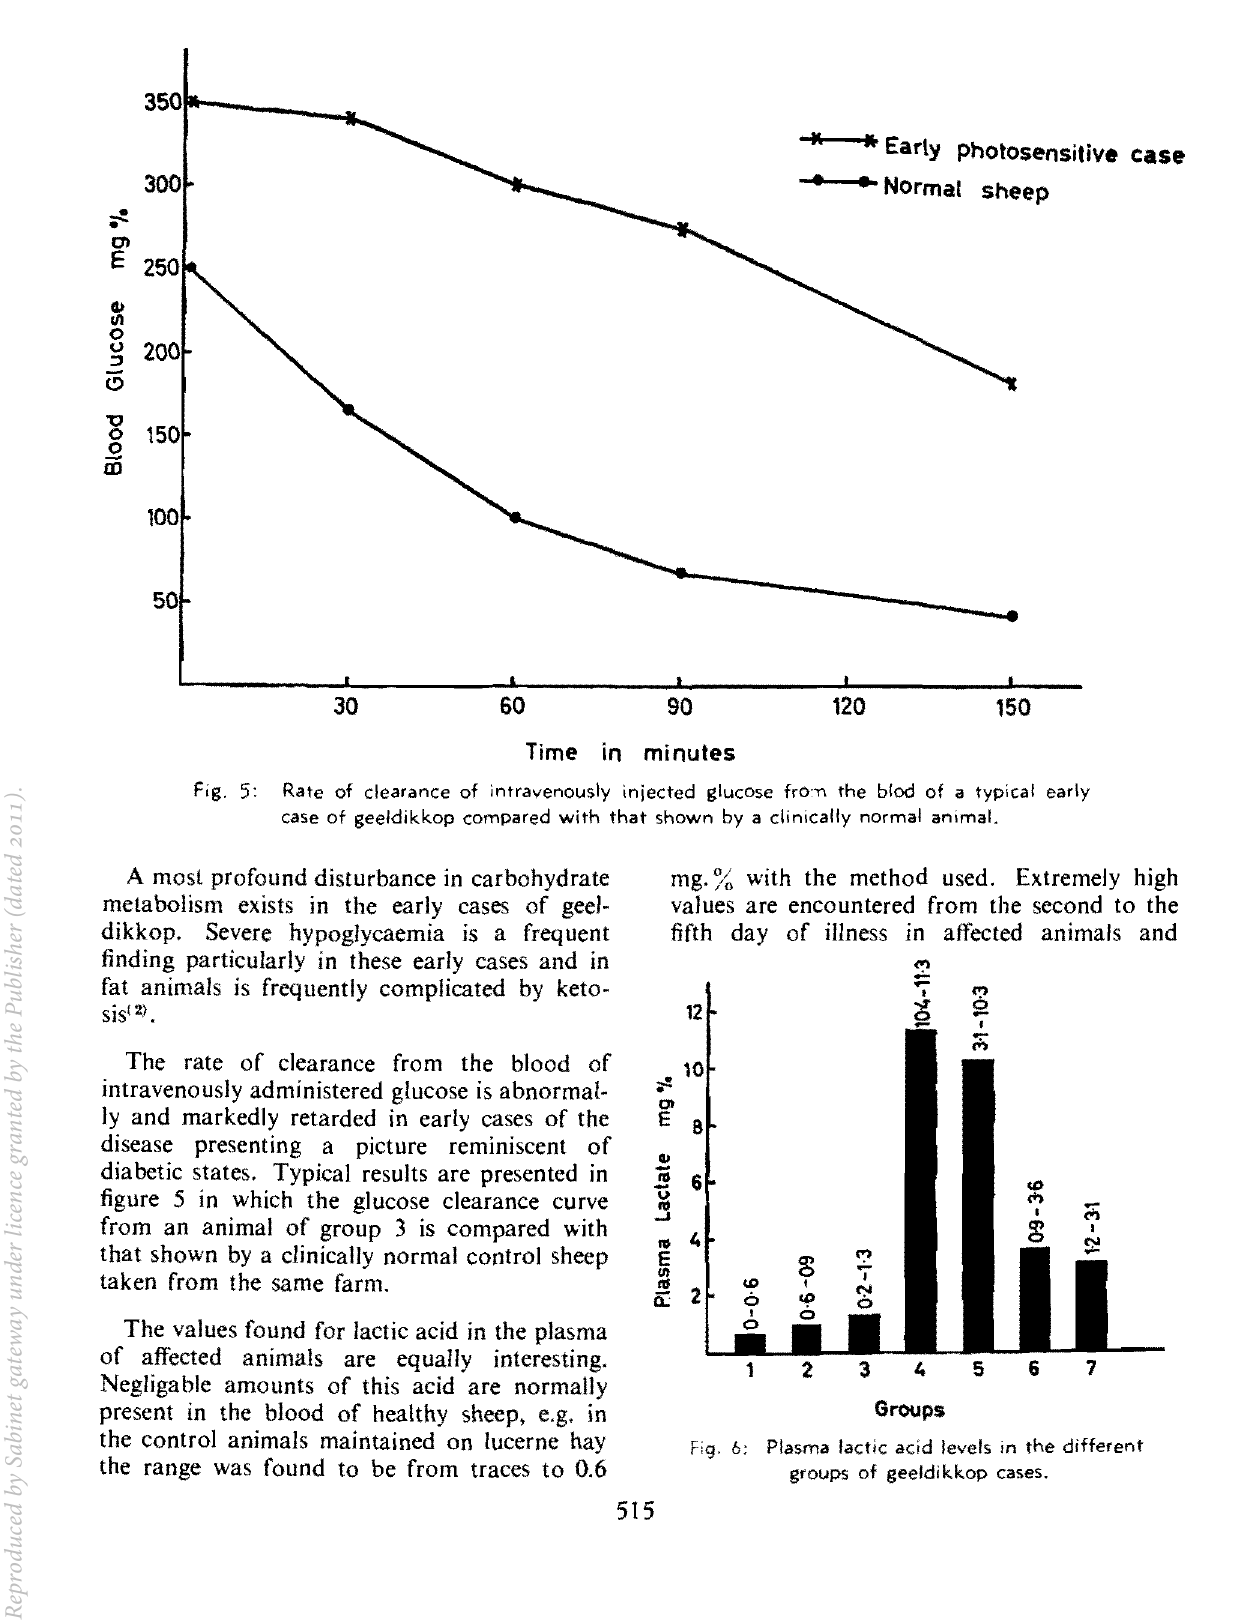
Fig. 5: Rate of clearance of intravenously injected glucose fro"T'I the blod of a typical early case of geeldikkop compared with that shown by a clinically normal animal.